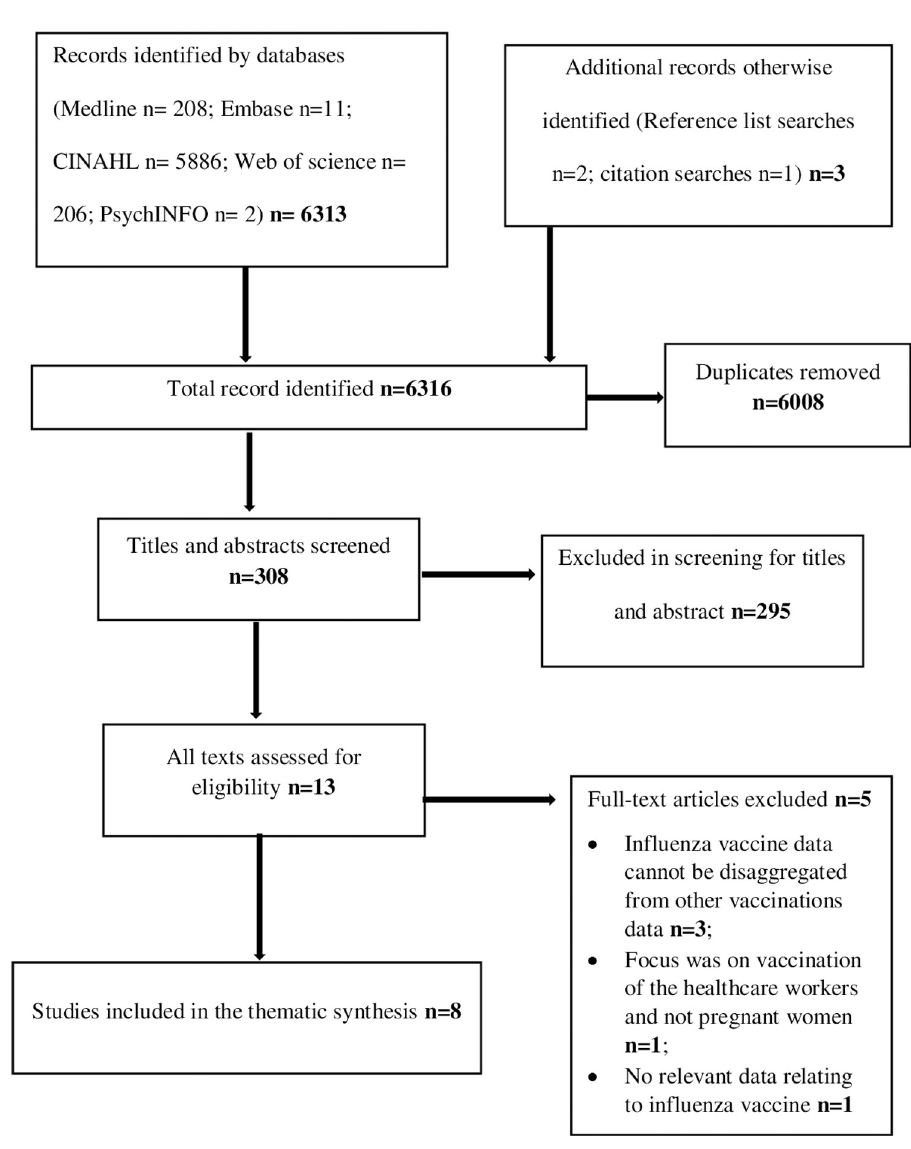
Fig 1. Flow diagram of systematic search and study